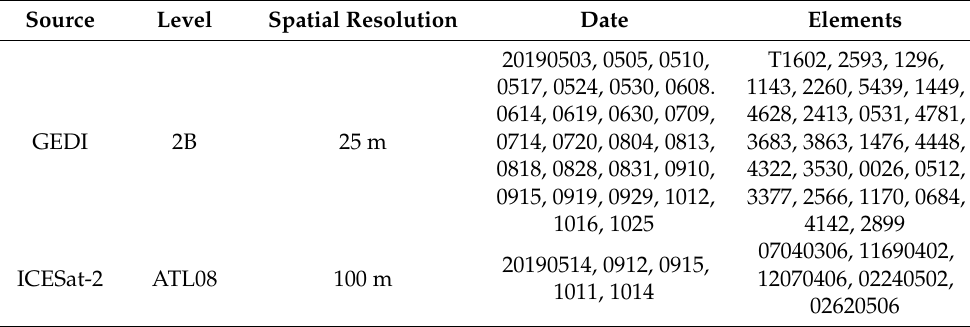
Table 2. The downloaded LiDAR dataset from GEDI and